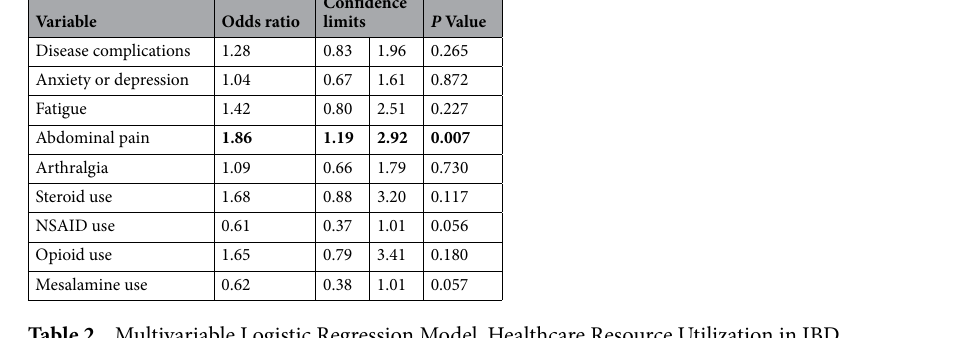
Table 2. Multivariable Logistic Regression Model, Healthcare Resource Utilization in IBD. IBD = inflammatory bowel disease, Disease Complications = intra-abdominal stricturing, fistulae and/or